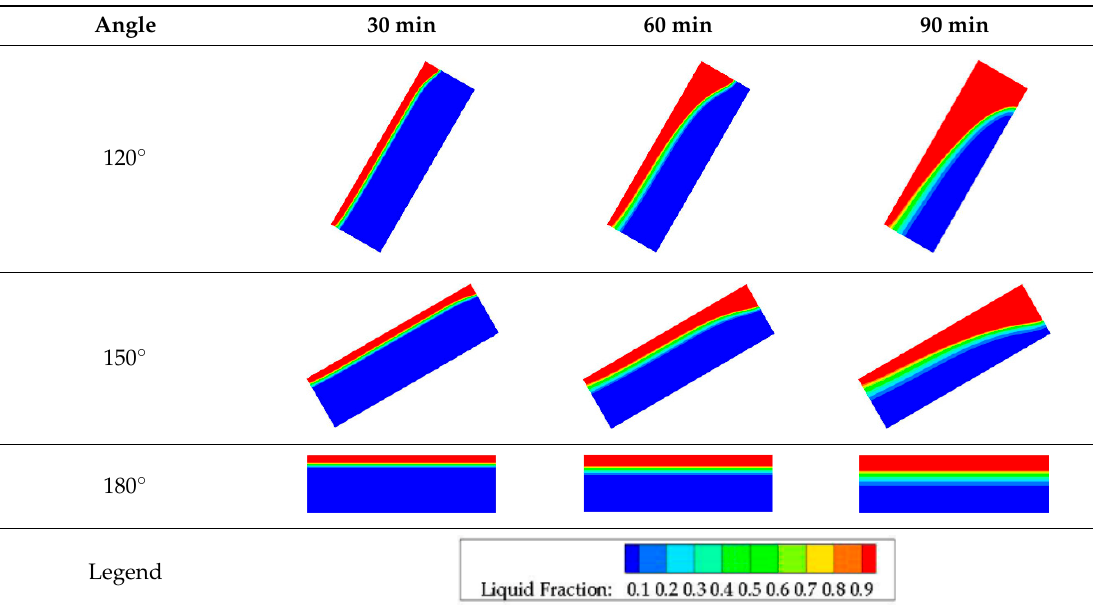
8 of 17 Figure 7. Results of time step independent analysis. 4. Results and Discussions 4.1. Model Validation The melting processes of paraffin are investigated by experiments and numerical simulations. The rectangular enclosure is placed at different angles (0°, 30°, 60°, 90°, 120°, 150° and 180°). Firstly, the shapes of solid liquid interfaces at three selected times (30 min, 60 min and 90 min) are compared by simulation. Table 3 shows the numerical results of solid liquid interfaces with different inclination angles at these selected times. Table 3. Comparison of the numerical results of solid-liquid interfaces with different inclination angles at three selected times. Angle